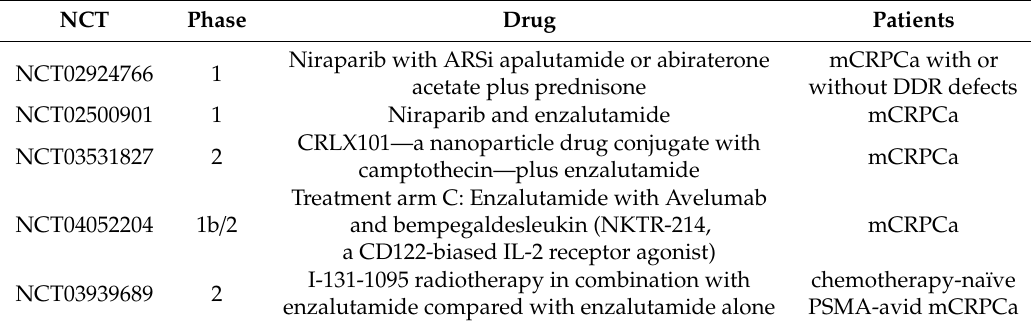
Table 2. Ongoing trials on AR-based novel drug